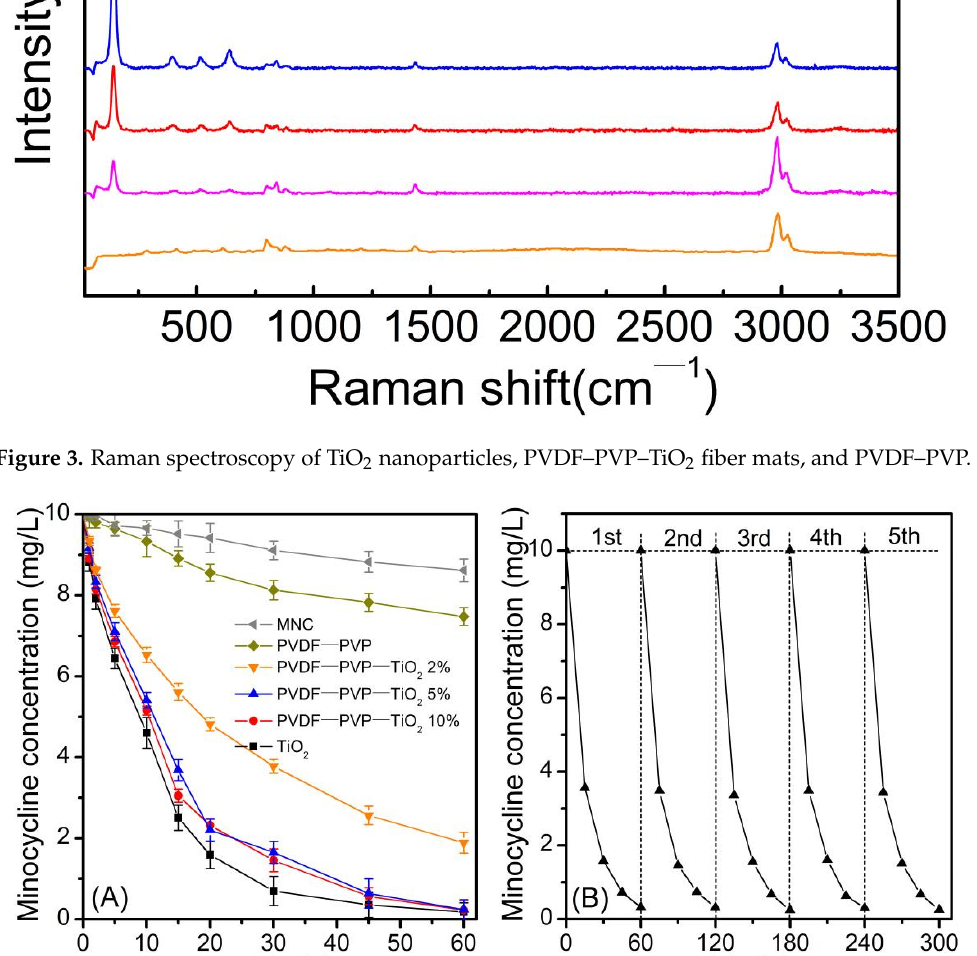
Figure 5. ESR spectra of ( A ) fiber mats (PVDF–PVP, PVDF–PVP–TiO 2 2%, and PVDF–PVP–TiO 2 5%) in DI water, ( B ) PVDF–PVP–TiO 2 5% with different solutions (DI water, 100 mM NaCl, 100 mM Na 2 SO 4 , 100 mM NaNO 3 , 10 mg/L mino- cycline (MNC), and 50 mg/L MNC), and ( C ) PVDF–PVP–TiO 2 5% with DI water and 100 mM NaHCO 3 . 3.3. Photocatalytic Degradation Kinetics of Minocycline The influences of the concentration of minocycline, pH values, the concentrations of inorganic anions (Cl − , SO 42 − , NO 3 − , and HCO 3 − ), and DOM concentrations on the minocy- cline degradation using PVDF–PVP–TiO 2 5% fiber mats were researched. The photocata- lytic degradation of minocycline followed pseudo-first-order kinetics (R 2 > 0.97). The k and t 1/2 were 0.006–0.121 min − 1 and 5.71–115.52 min, respectively (Table S4). 3.3.1. Effect of Initial Concentration of Minocycline Some investigations have reported that the concentration of pollutants is an im- portant factor in water treatment [31]. Therefore, the influences of the minocycline con- centration on the photocatalytic degradation rate were researched at 10–50 mg/L. The re- sults are presented in Figure S3. The photocatalytic degradation rate of minocycline was significantly affected by the initial concentration. The degradation rate of decrease was more obvious at a lower initial concentration (Figure S3). At a higher initial concentration,